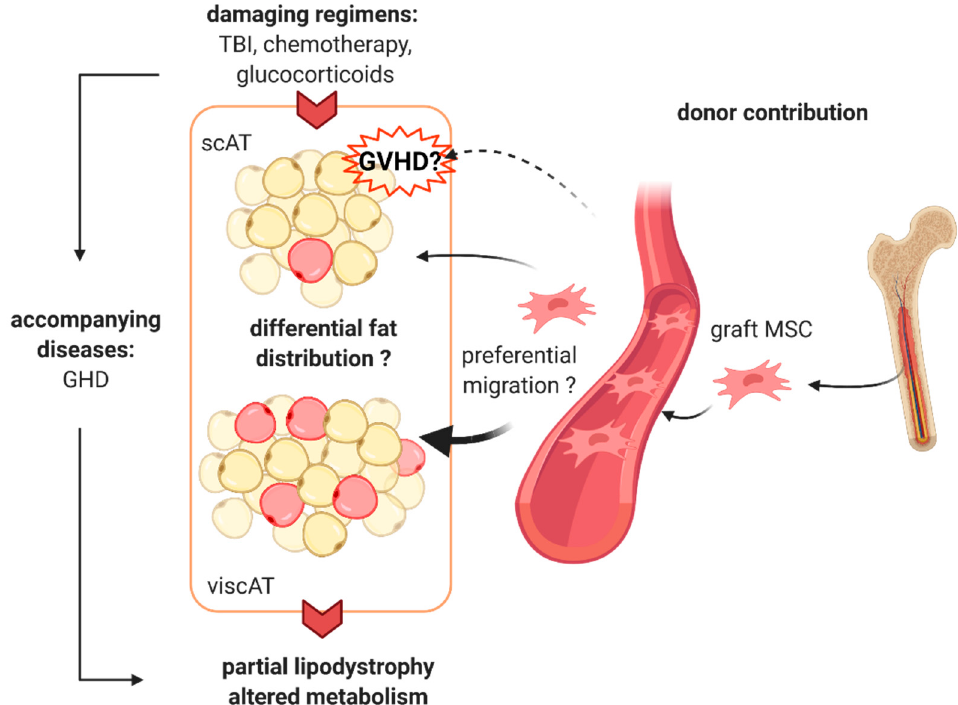
Figure 1. Proposed mechanism of hematopoietic stem cell transplantation (HSCT)-associated lipodystrophy. Total body irradiation (TBI) causes damage to the adipose tissue, most likely by inhibition of preadipocyte expansion and by causing treatment-related endocrine complications, e.g., growth hormone deficiency (GDH). Pharmacologic treatment during myeloablative conditioning and the use of glucocorticoids may further accelerate the disease. Graft versus host disease (GVHD) may be involved in fat loss at the subcutaneous adipose tissue (scAT) level. Donor-derived mesenchymal stem cells (MSC) migrate into the host adipose tissue, where they differentiate into adipocytes and gradually replace the host cells. Preferential migration to the visceral adipose tissue (viscAT) might further contribute to the altered body fat distribution as seen in partial lipodystrophy. The image was created with BioRender.com (created 31 March